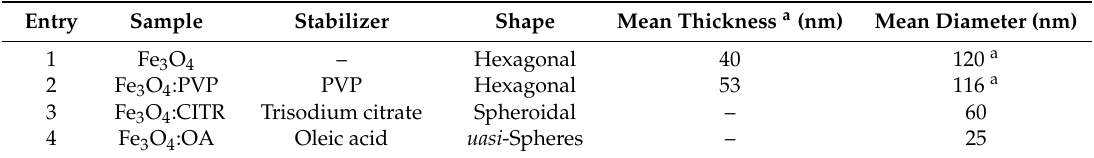
Table 1. Morphological features of Fe 3 O 4 nanoparticles synthetized by microwave-assisted hydrothermal procedure [36] a Corresponding to the facet to facet distance.